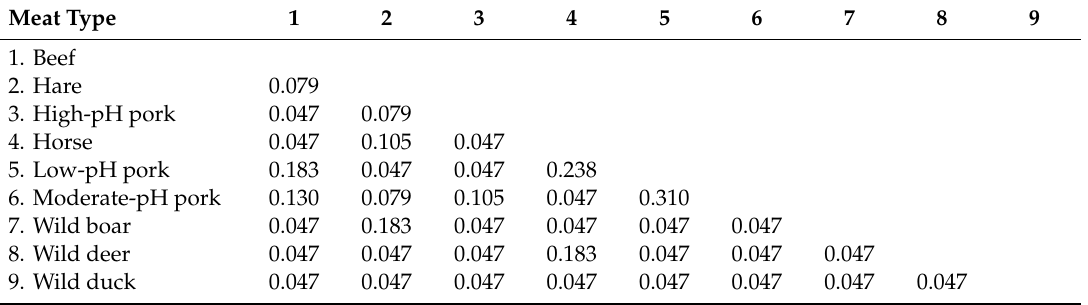
Table 4. P values based on pairwise comparisons between all meat fermentation samples using PERMANOVA on a distance